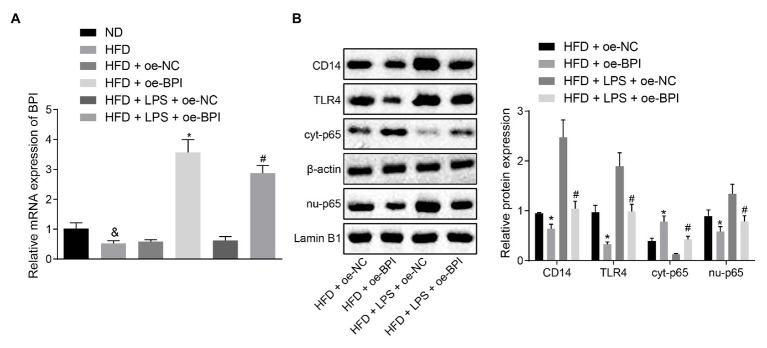
Forced BPI expression disrupts the LPS-CD14-TLR4 signaling pathway and then inhibits the NF-κB signaling pathway. (A) The expression of BPI in the hippocampal tissues of mice in each group examined using reverse transcription quantitative polymerase chain reaction (RT-qPCR). (B) Western blot analysis of CD14, TLR4, and NF-κB p65 proteins in hippocampal tissues of mice in each group. &p < 0.05 vs. mice fed with ND. *p < 0.05 vs. HFD mice injected with oe-NC. #p < 0.05 vs. HFD mice injected with LPS and oe-NC. The results were measurement data and expressed as mean ± standard deviation. Data between two groups were compared by independent sample t-test.